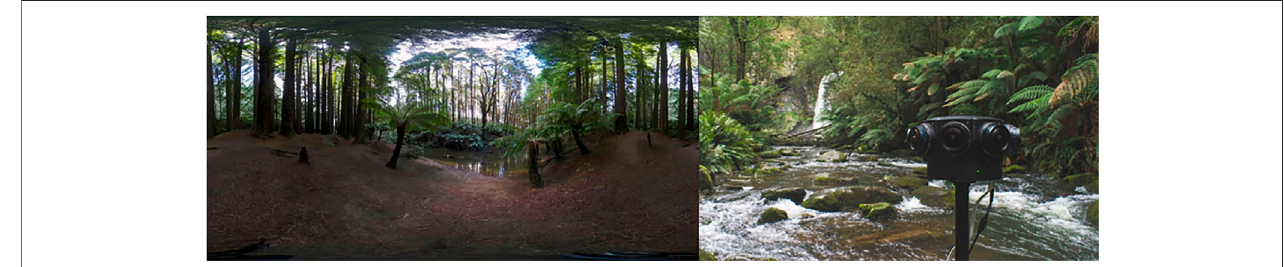
FIGURE3| Filminglocationsfortheforestenvironmentin Place .Theimageontheleftshowstheenvironmentpresentedforthe fi rsthalfofthemindfulnesspractice. The image on the right shows the second environment as well as the camera used to capture the omnidirectional footage. See Seabrook et al. (2020).